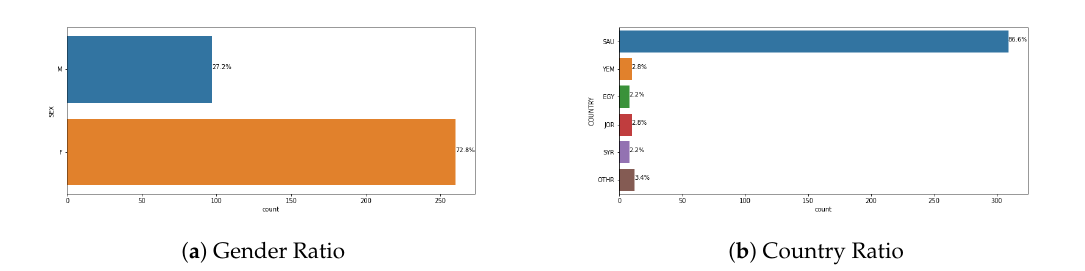
Figure 1. Bar charts showing the demographic information of the